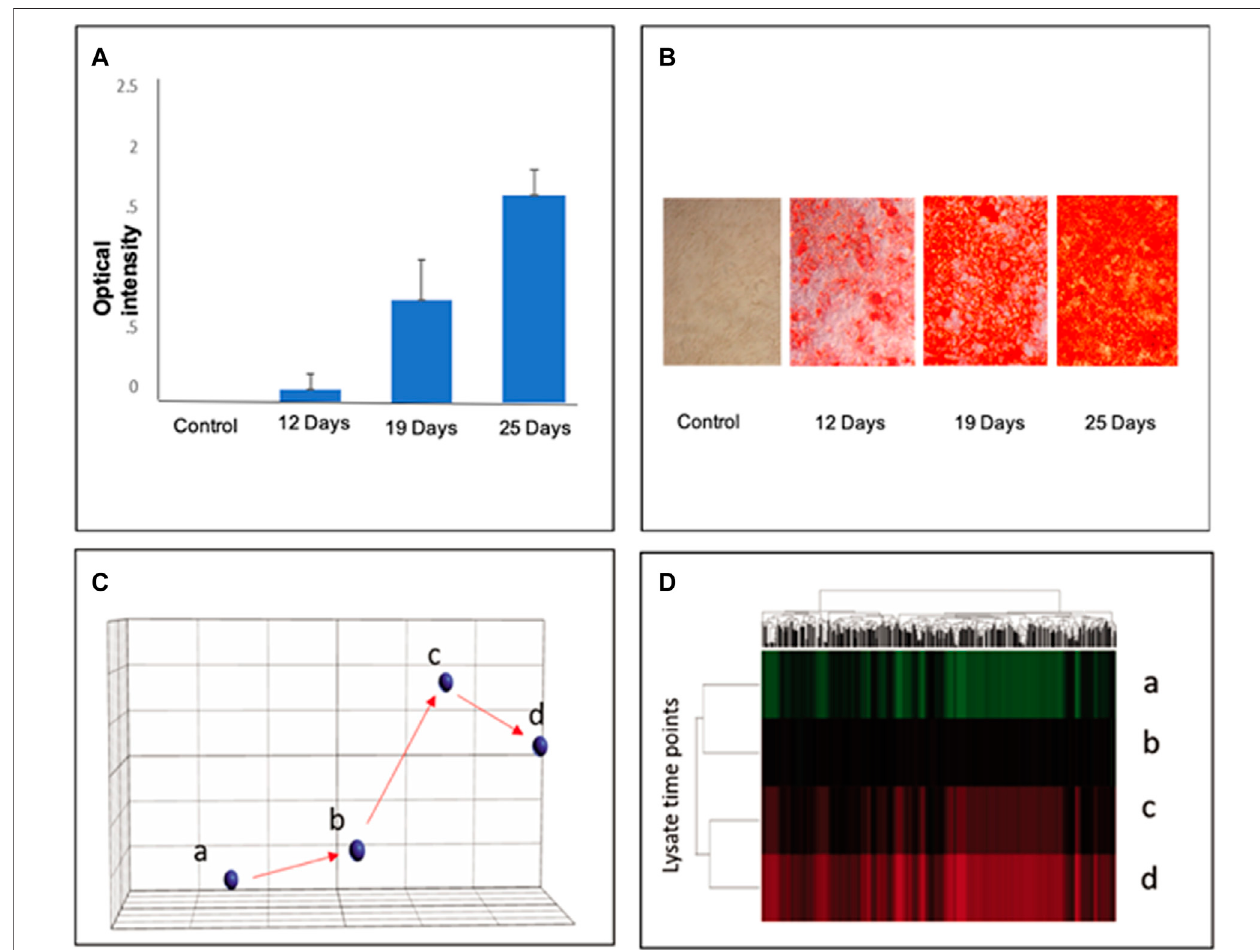
FIGURE 1 | Stepwise differentiation of MSCs at days 12, 19, and 25. Alizarin Red staining con fi rmed the differentiation of MSCs into osteoblasts in culture to visualize calcium deposition. (A) : The staining intensity of Alizarin Red was quanti fi ed to re fl ect the percentage of osteogenic differentiation of MSC lysates; error bars represent s.e.m. (B) : Visual representation of differentiated cell density in culture. (C) Principal component analysis (PCA) of gene pro fi les from bone marrow MSC cell lysates at varying stages of differentiation: a – MSCs; b – D12; c – D19; D25 days after osteoinductive differentiation. (D) Hierarchical clustering shows signi fi cant differences among the three groups determined by ANOVA ( p < 0.05) (Refer to Supplementary Table S1 for a total of 22,056 genes in the normalized counts and statistics).